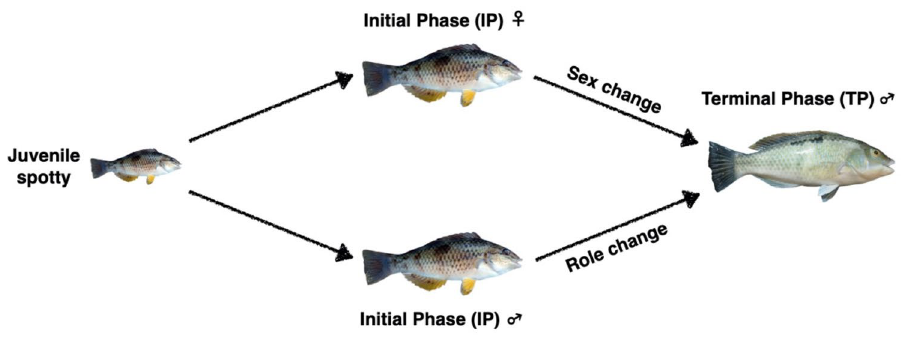
Figure 1. Life cycle of New Zealand spotty wrasse ( Notolabrus celidotus ). Juveniles first develop into either initial phase (IP) females or males, which can then become terminal phase (TP) males via sex or role change, respectively. Adapted from 31,87 . IP New Zealand spotty wrasse image by Allan Burgess, TP New Zealand spotty wrasse image by Jodi